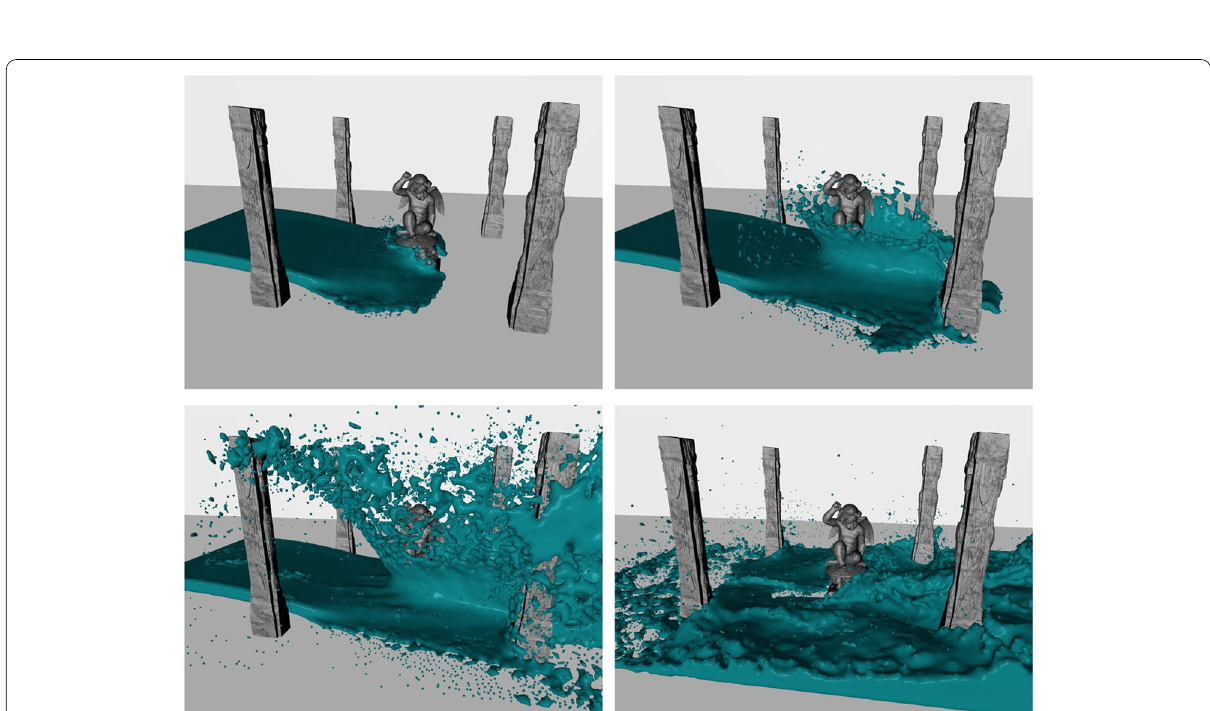
Fig. 9 Visual simulation of a fluid flooding the ruins, using the VSLSPH method (200000